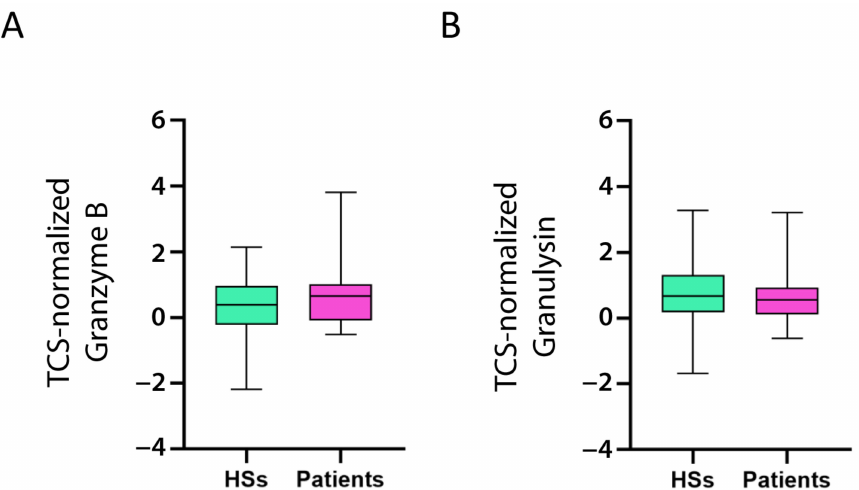
Figure 6. Expression of activated CD8 + T cell markers in HSs and patients with B-ALL. Granzyme B ( A ) and Granulysin ( B ) mRNA expression (log2) in patient and healthy subject (HS) PBMC was normalized with the T cell signature (TCS) expression levels (log2). The box limits represent the 1st and 3rd quartiles. The median is represented as a line within the box. The whiskers go down to the smallest and up to the largest value. The significant difference between patients and HSs was evaluated using the t -test and Mann–Whitney test. Expression values do not